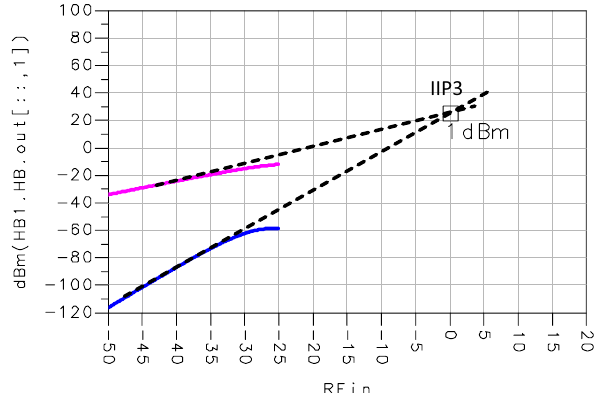
Figure 8. Third input intercept point (IIP3).